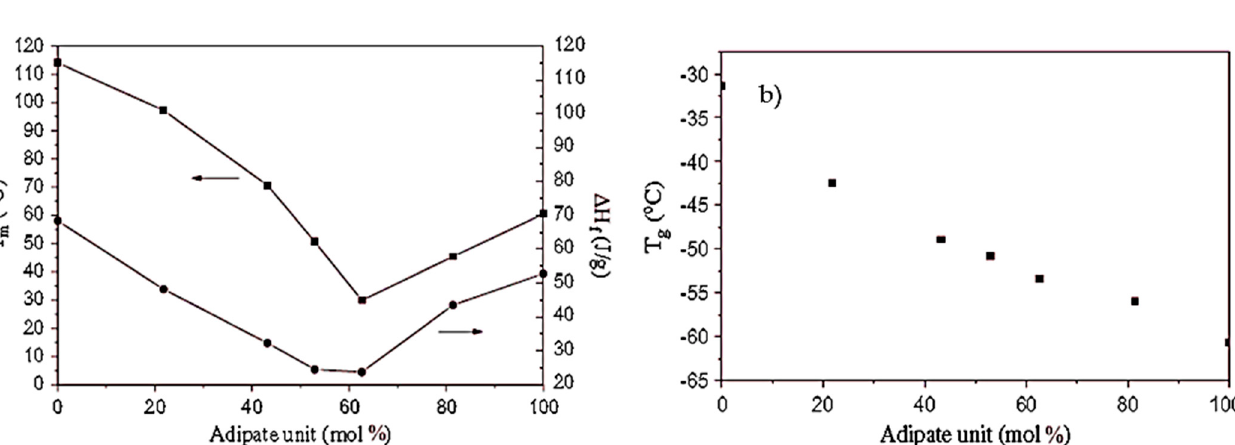
Figure 5. Standard DSC melting curves of PBS samples crystallized at different temperatures as indicated. The heating rate is 10 °C min. The dashed lines are the indications of four melting peaks.